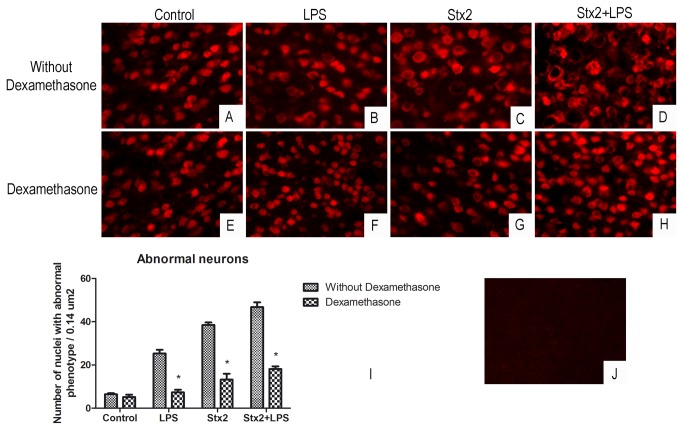
Dexamethasone decreases the percentage of degenerative neurons.Micrographs show the expression of NeuN by immunofluorescence in mice motor cortex immunolabeled with anti-NeuN antibody after four days of treatment with saline (A and E), LPS (B and F), Stx2 (C and G), Stx2+LPS (D and H) followed by i.p. injection of saline (A through D) or Dexamethasone (E through H). Dexamethasone protected neurons from the cytotoxic action of LPS, Stx2 and Stx2+LPS (I). J: negative control by not adding the primary antibody. *: significant differences between mice treated with Dexamethasone and those treated with saline (p <0.001).